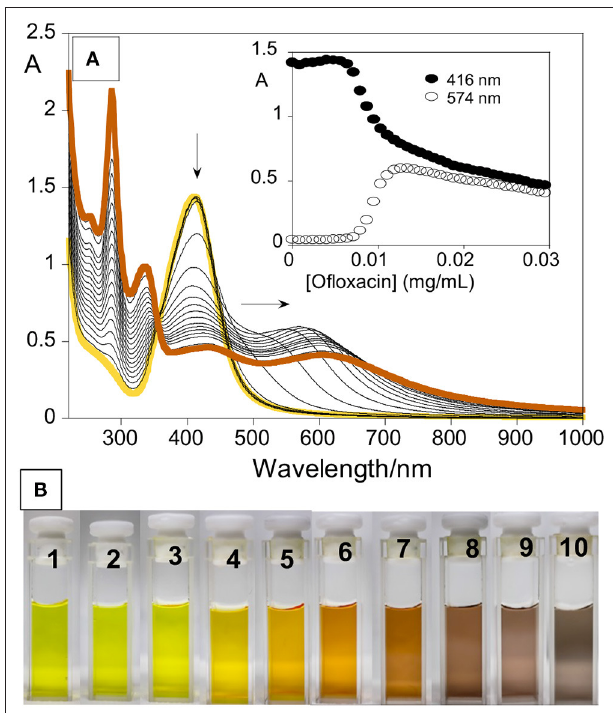
FIGURE 2 | (A) Spectrophotometric titration of AgNPs with increasing amounts of ofloxacin in water. Inset represents the absorption as a function of ofloxacin concentration (mg/mL) at 416nm and 574nm. (B) Naked-eye colorimetric response of AgNPs with increasing amount of ofloxacin; 1–0,